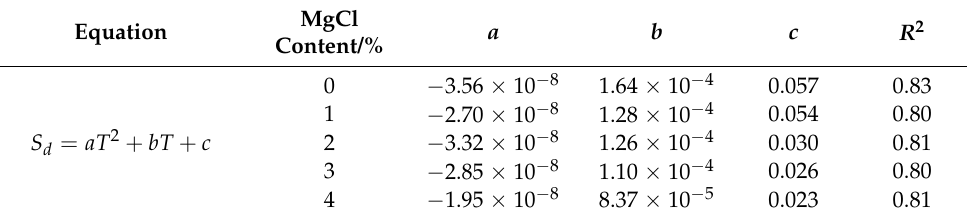
Figure 6. The drying shrinkage rate of specimens. Table 3. The fitting results of drying shrinkage rate and the curing age ( T ).